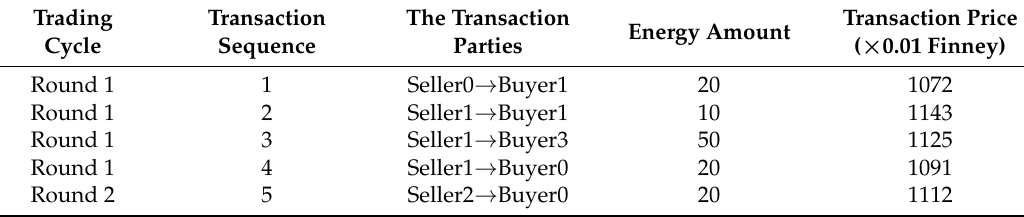
Table 10. The transactions’ information over the trading cycle .